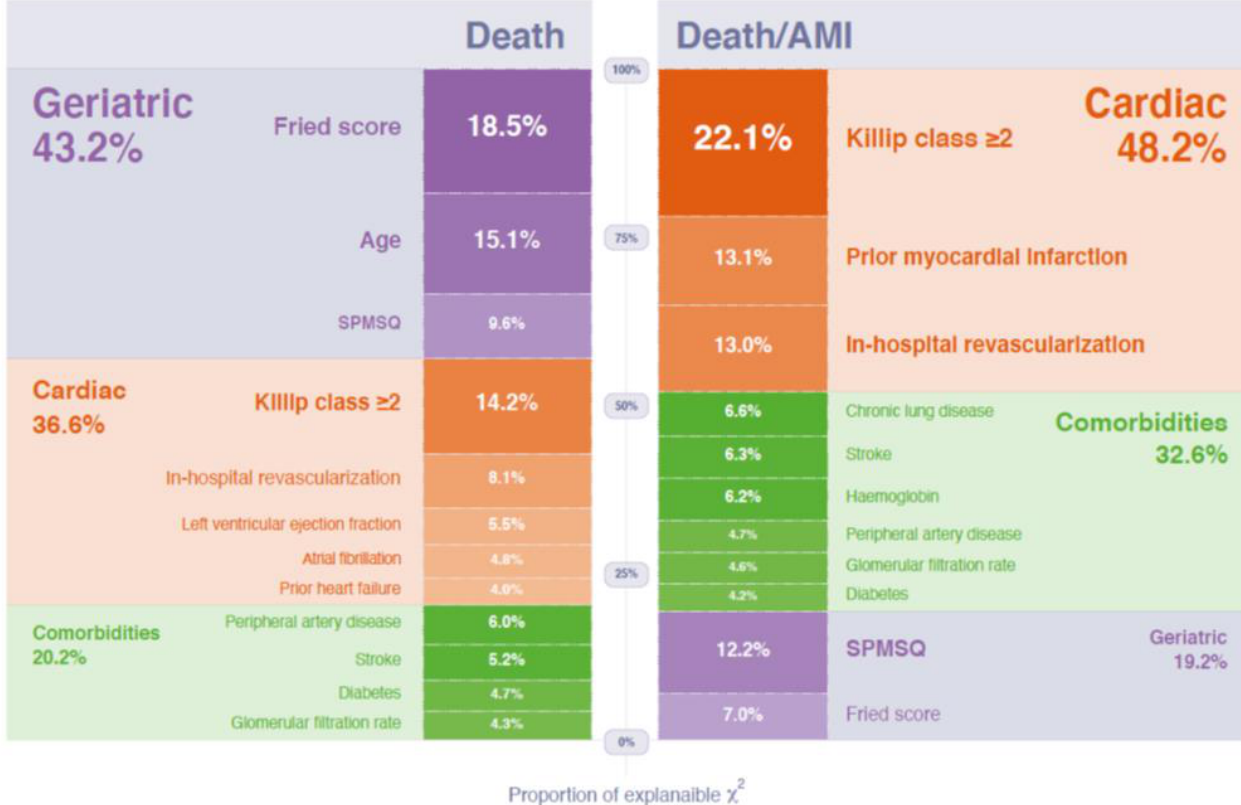
Figure 2. Relative importance of the variables included in the Cox models as a percentage of the overall chi-square explained by each variable, for death or myocardial infarction (top) or death (bottom). Abbreviations: AMI = acute myocardial infarction. SPMSQ = Short Portable Mental Status Questionnaire. Table 5. Multivariable model for mortality (total number of deaths = 216).